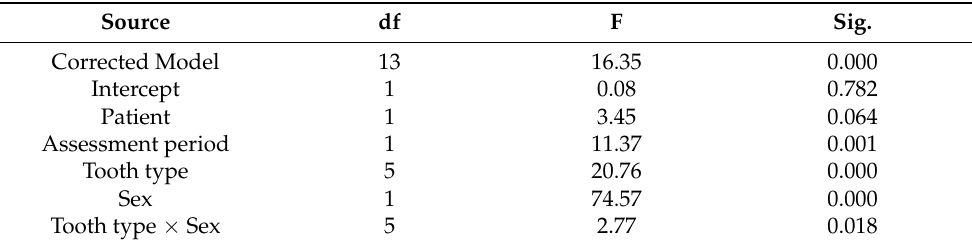
Table 3. Results of the ANCOVA testing the effect of tooth type and sex on the detected tooth wear amount after controlling for the patient and duration of assessment period.